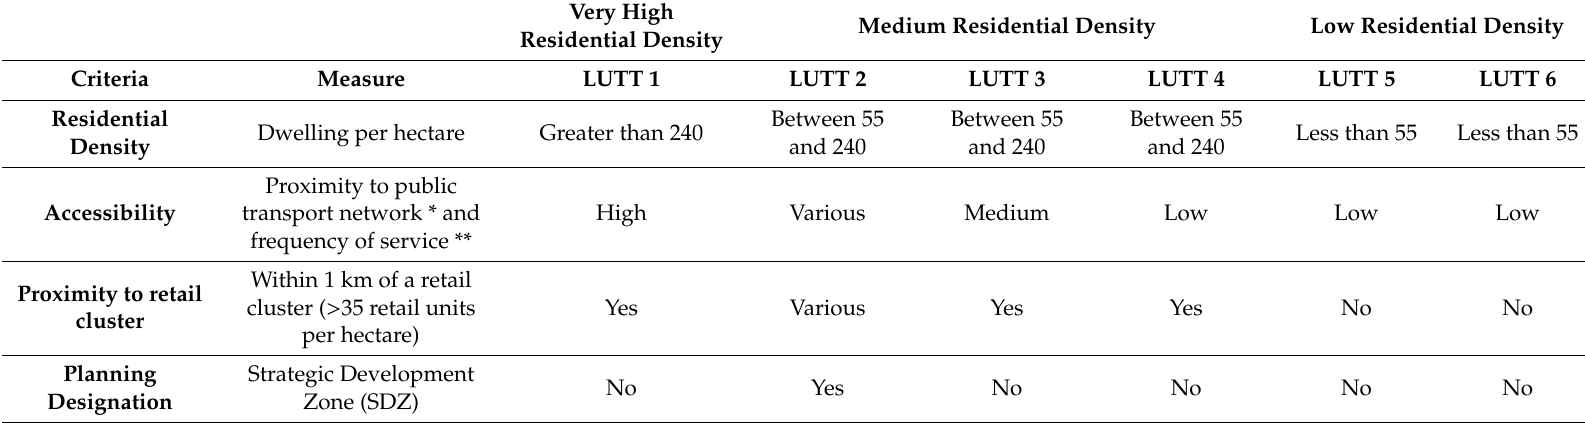
Table 1. Description of Six Land Use–Transport Typologies, showing Key Selection Criteria.